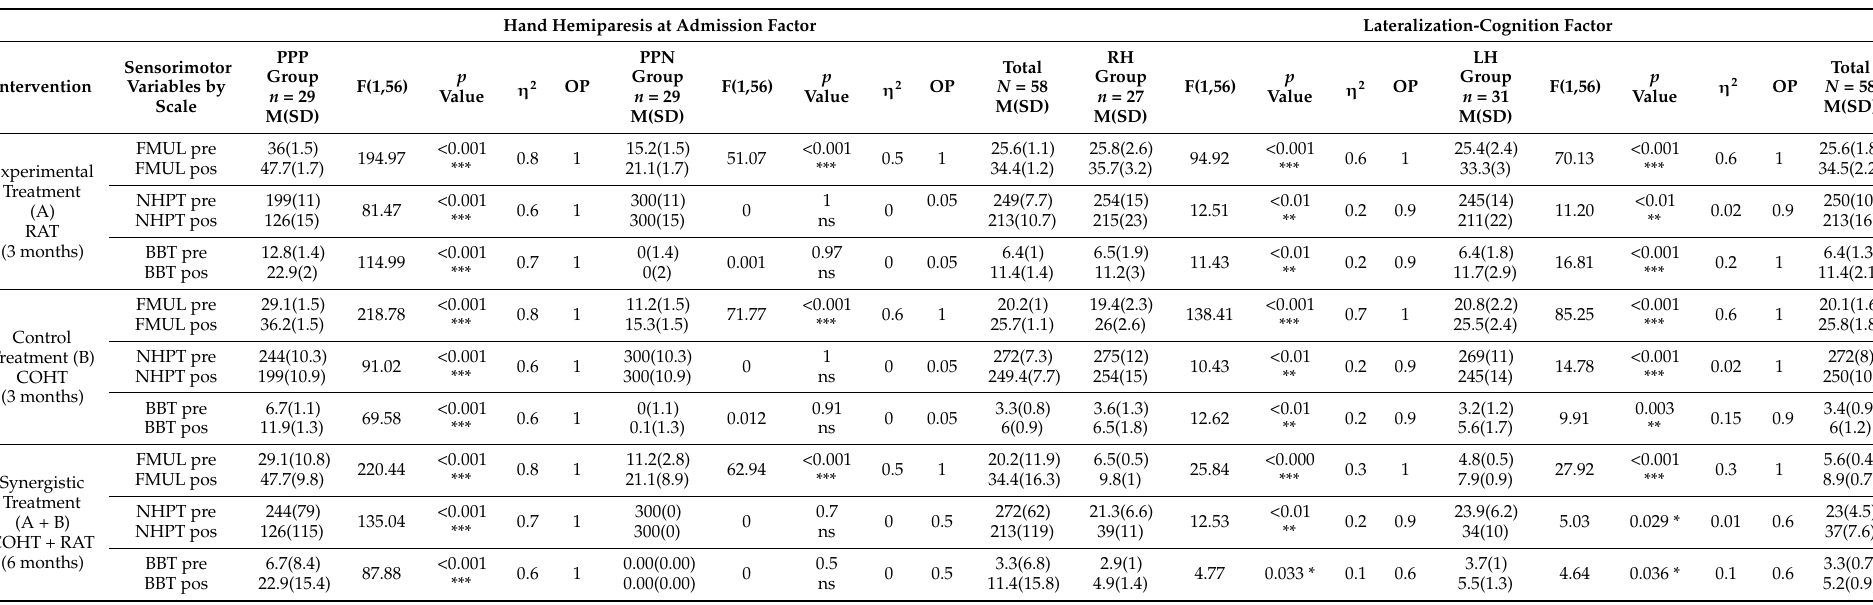
Table 2. Sensorimotor effects of COHT and RAT treatments at 3 and 6 months by both prognosis (PPP, PPN) and lateralization-cognition groups (RH, LH). Hand Hemiparesis at Admission Factor Lateralization-Cognition